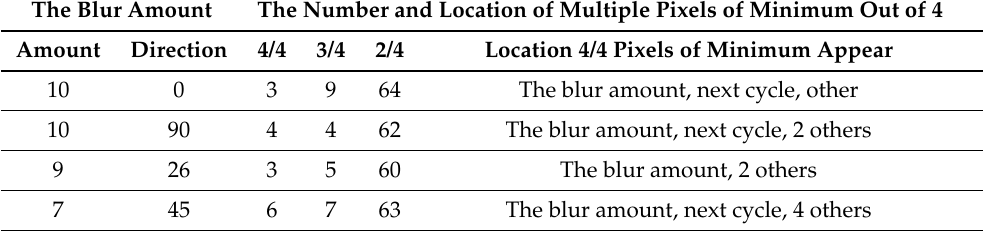
Table 14. Shade of different components; The number of the pixels and their locations where multiple pixels of minimum appeared out of four sub-images out of area E and F. The Blur Amount The Number and Location of Multiple Pixels of Minimum Out of 4 Amount Direction